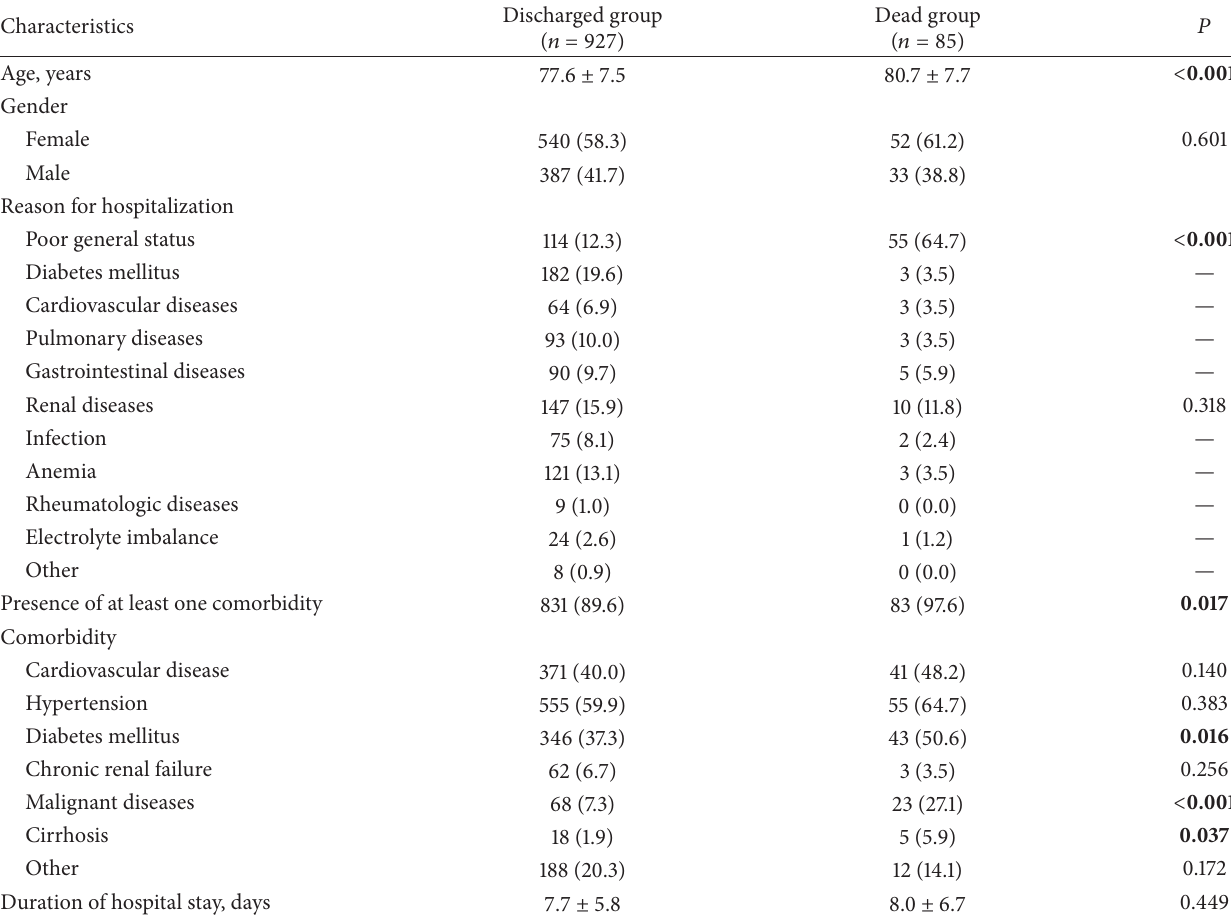
Table 2: General characteristics of the discharged and dead